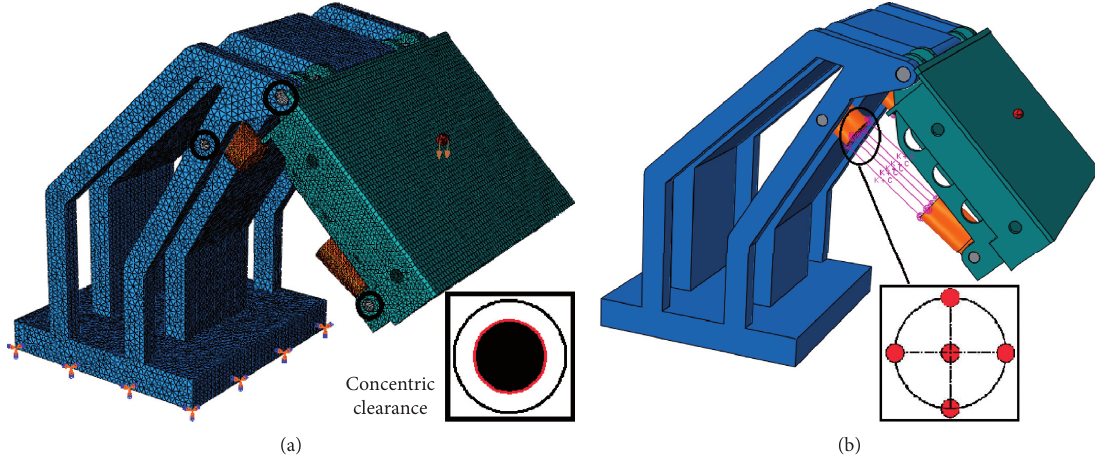
Figure 5: Finite element simulation model with multiclearance. (a) Mesh and boundary conditions. (b) Position of the spring and